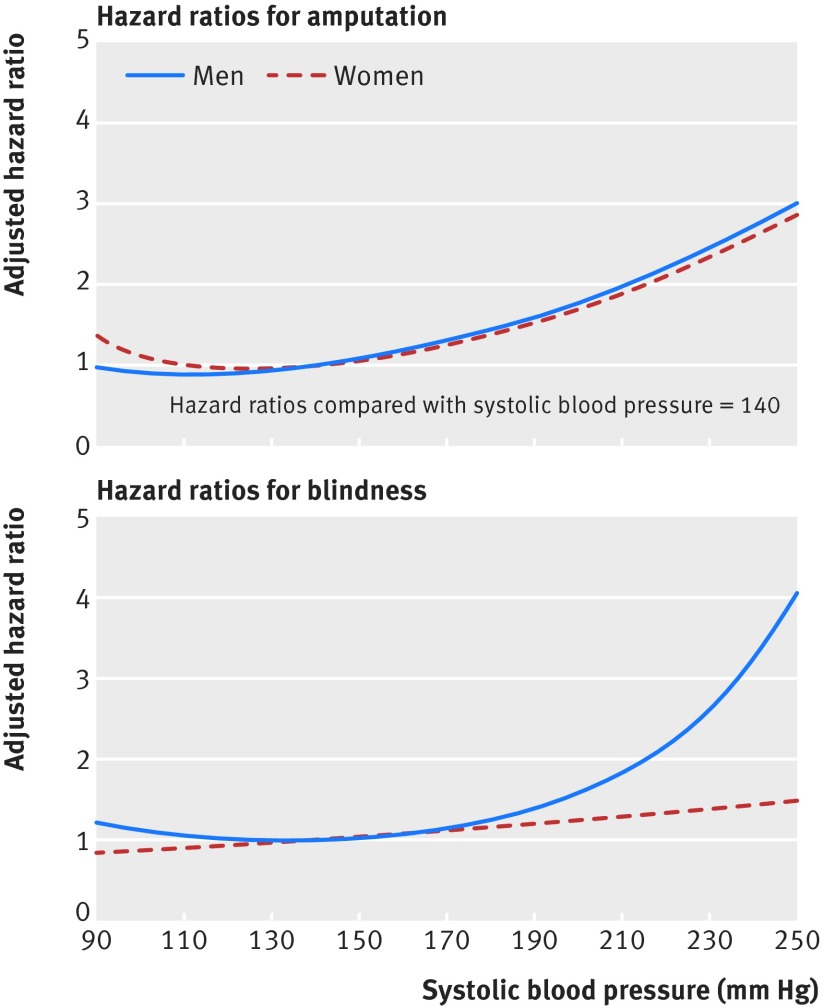
Fig 3 Adjusted hazard ratios for blindness and lower limb amputation by systolic blood pressure in derivation cohort